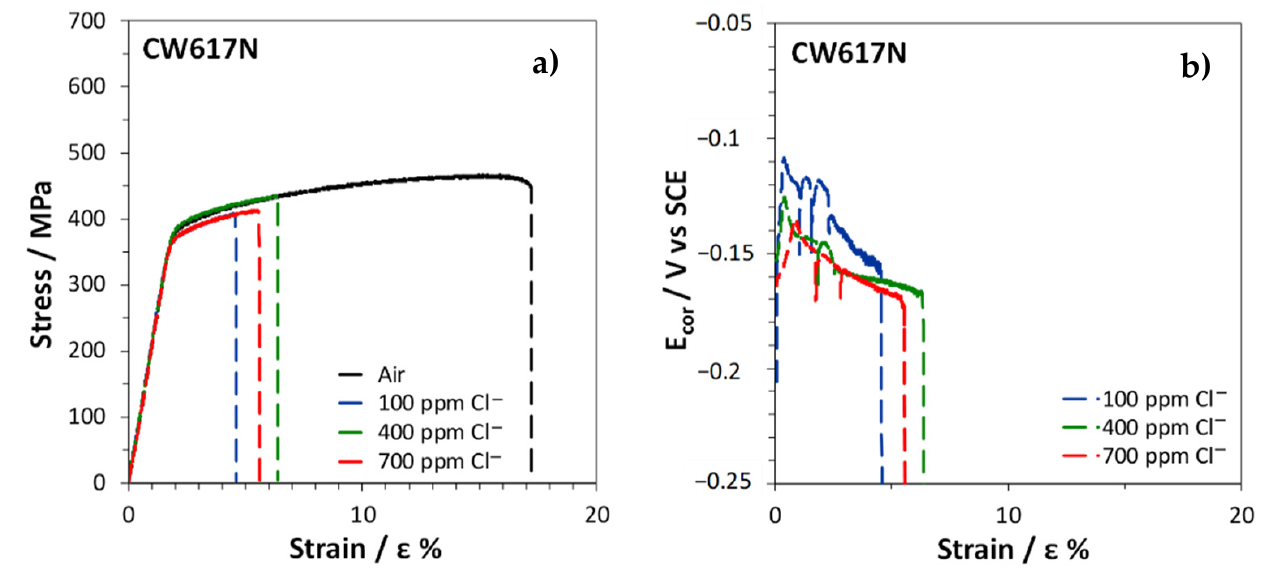
Figure 11. SSRT on CW617N: ( a ) stress vs. strain curves obtained in air and in SDW solutions and ( b ) E cor values recorded in SDW solutions.